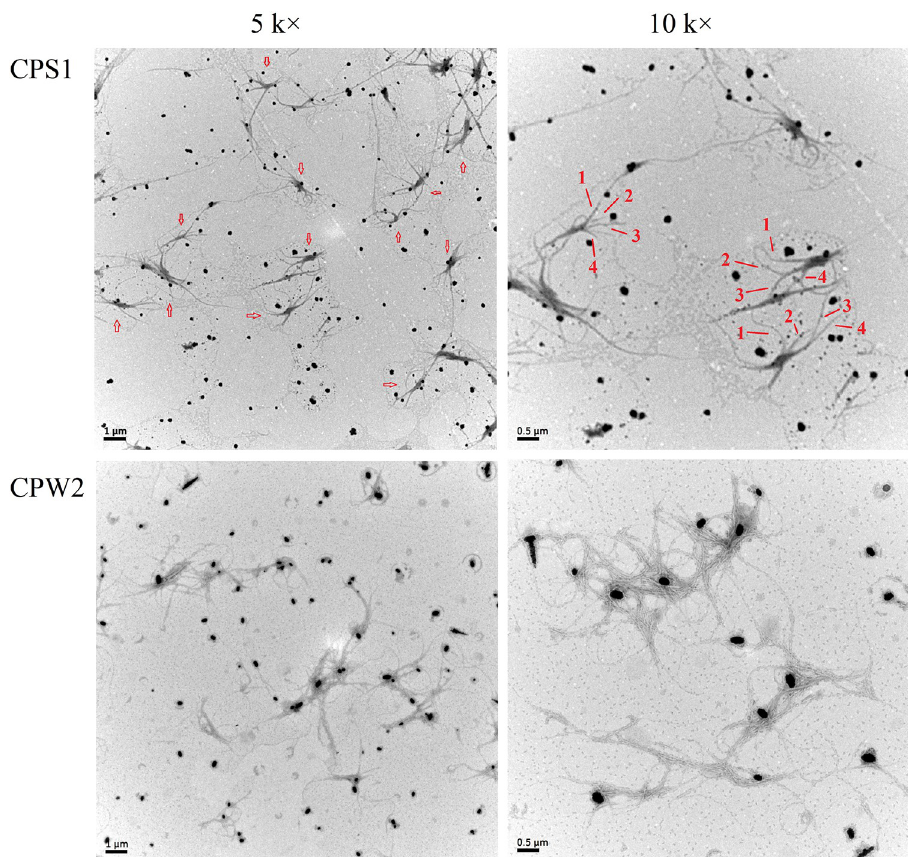
Fig 5. TEM images of CPS1 and CPW2 (5 k × , 10 k × ).